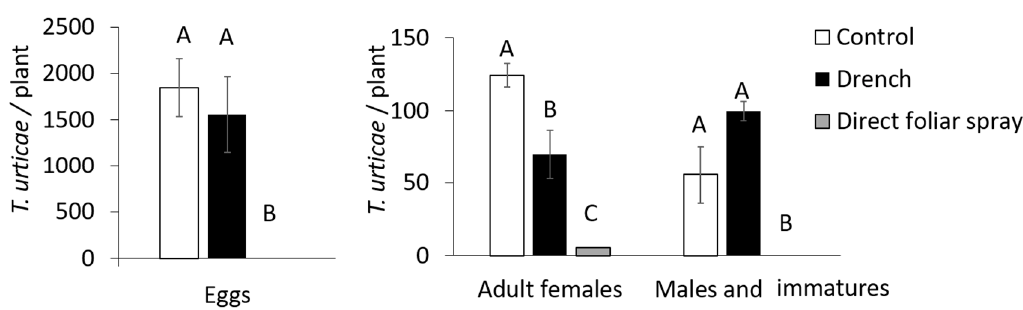
Figure 7. E ff ect of application of Mb7 (10 7 conidia mL − 1 ) as a drench or foliar spray on number of eggs, adult females, males and immatures of Tetranychus urticae two weeks after treatment on bean plants. Di ff erent letters above the columns indicate significant di ff erence (Eggs: DF = 2, F = 9.87, p < 0.005; females: DF = 2, F = 34.85, p < 0.0001; males and immatures: DF = 2, F = 9.02, p < 0.005).